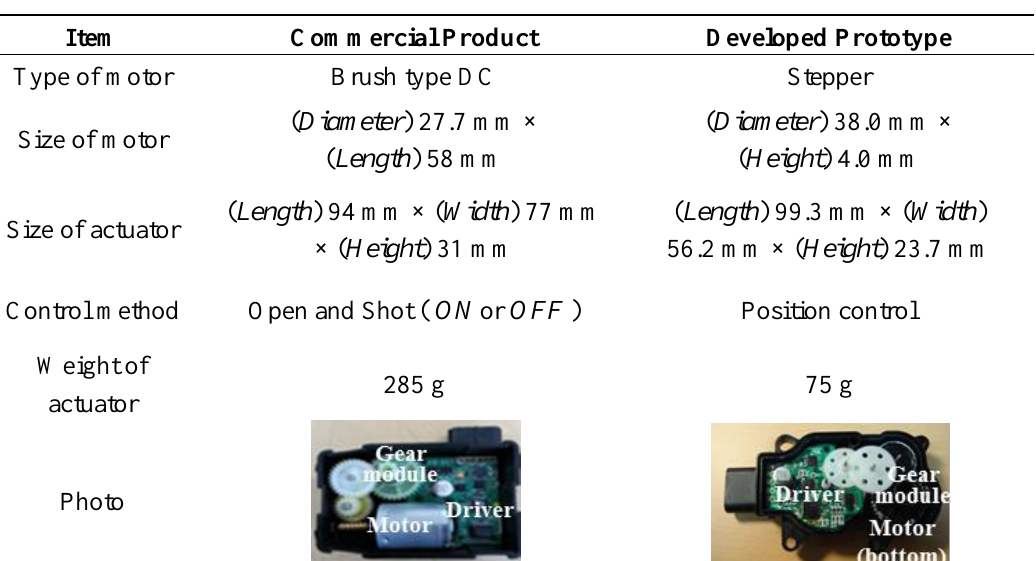
Table 2. Comparison of actuator (commercial model vs. developed